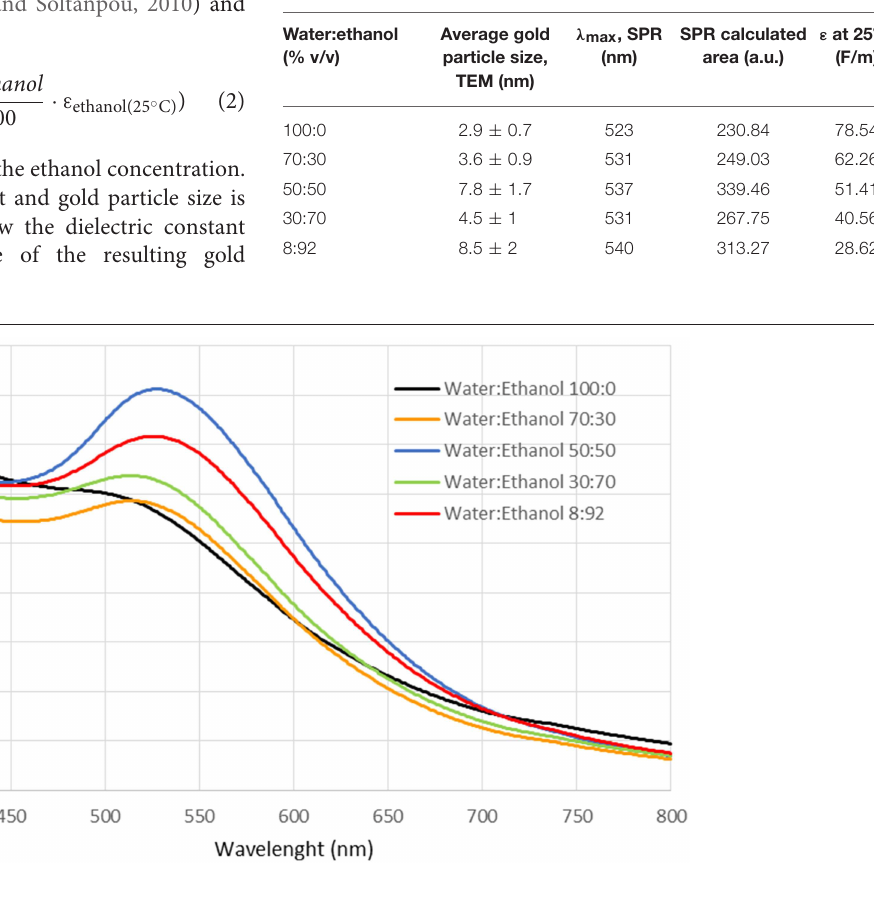
Frontiers in Chemistry |